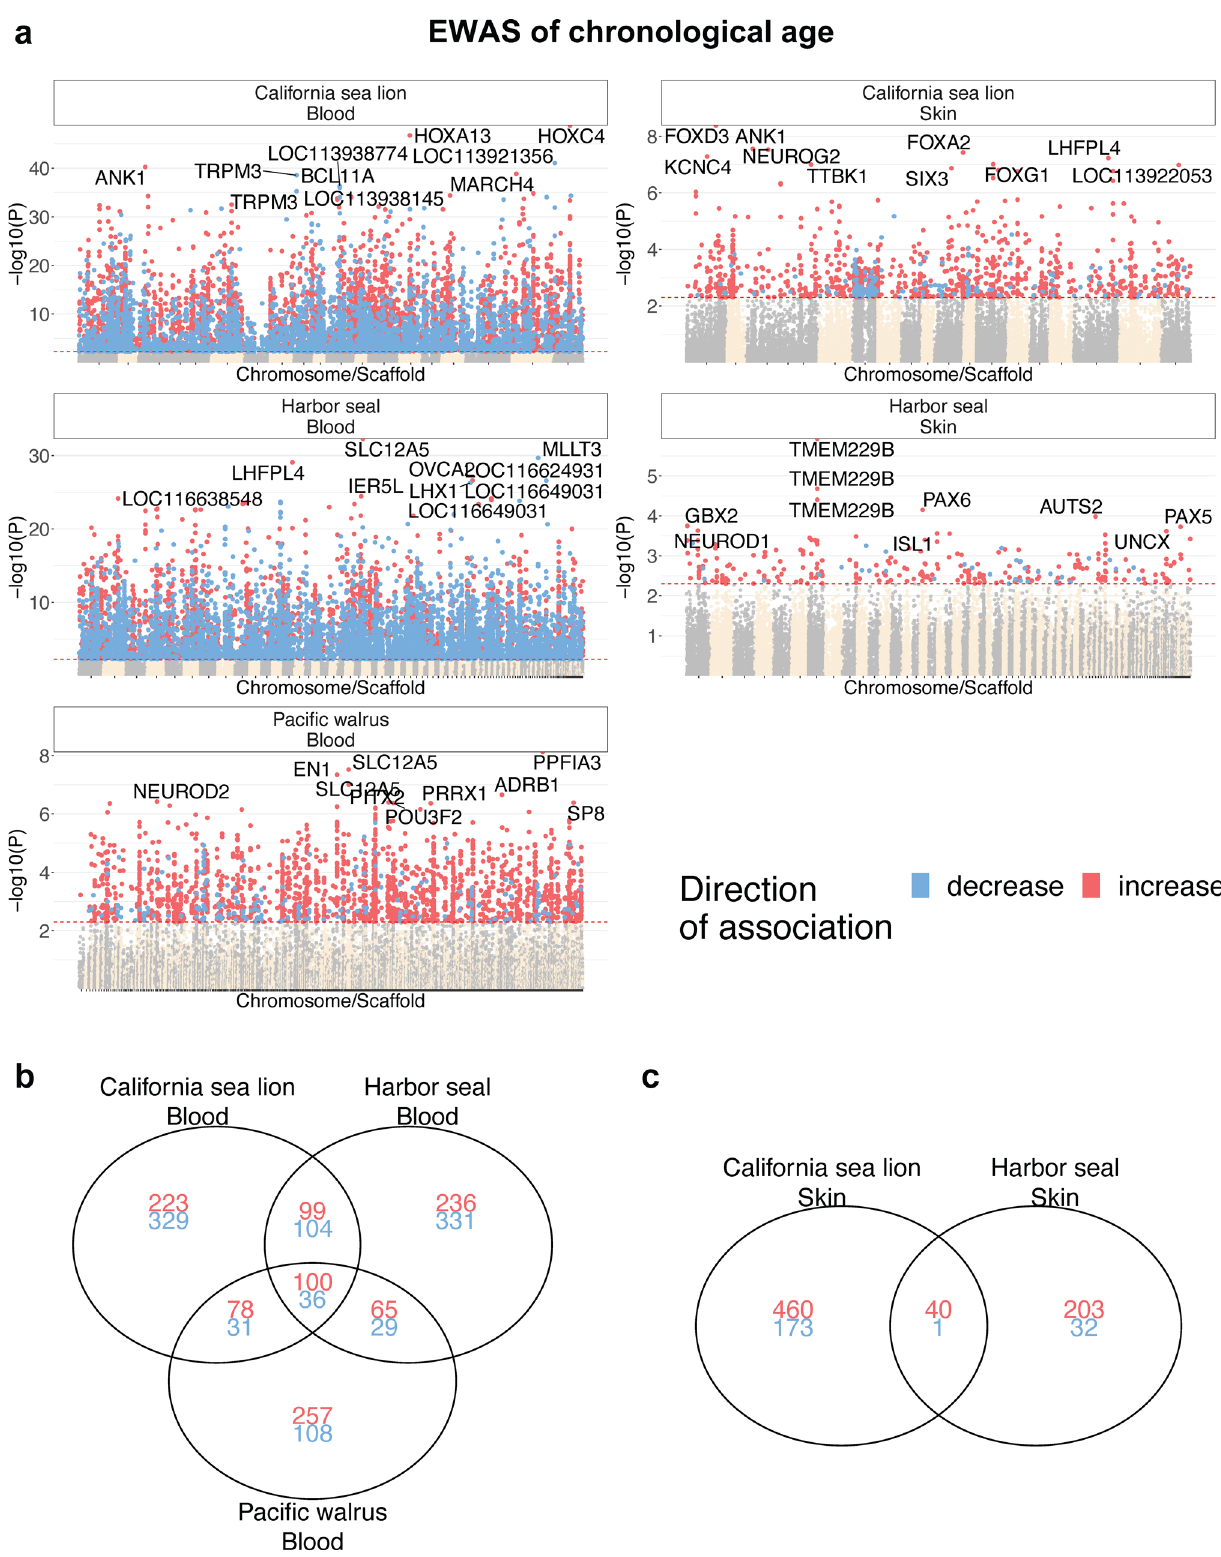
Fig. 3 Epigenome-wide association study (EWAS) of chronological age in skin or blood of three pinniped species. a Manhattan plots of the EWAS of chronological age. The coordinates are based on the alignment of the probes to the corresponding genome for each species (oros_1.0, gsc_hseal_1.0, and zalcal2.2). The direction of the associations as determined by a Pearson correlation test p value (unadjusted p < 0.005, red dotted line) are colored in red (age-related increase) and blue (age-related decrease), respectively. The top 15 CpGs were labeled by the neighboring genes. b , c Venn diagrams representing the overlap of top 500 positively and top 500 negatively age-associated CpGs in each pinniped tissue. Results for all CpHs are provide in Supplementary Table